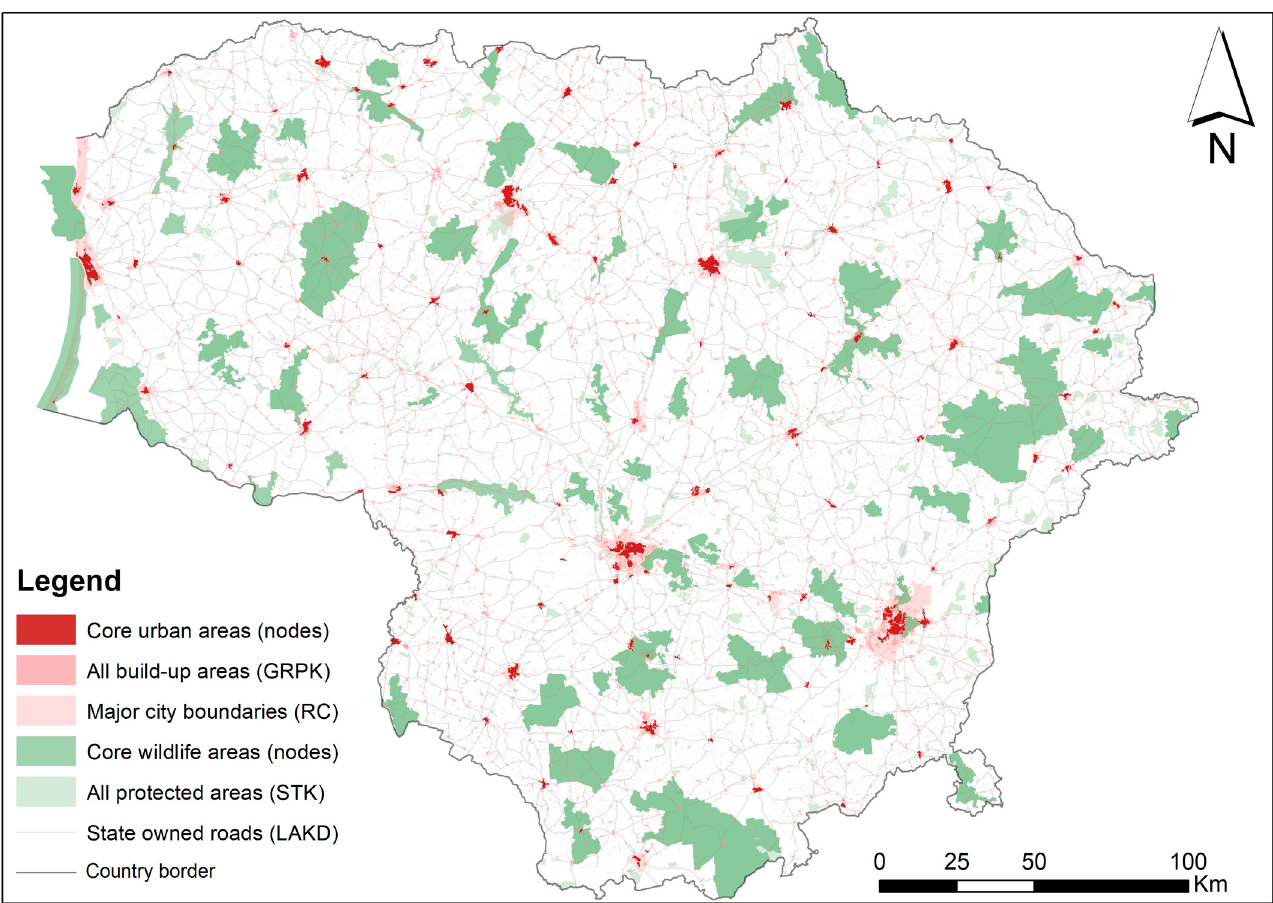
Figure 3. Urban and wildlife core areas used as nodes for urban and wildlife corridor identi fi cation. Build-up, city boundary, protected areas and state-owned roads are shown as reference (Table 3).